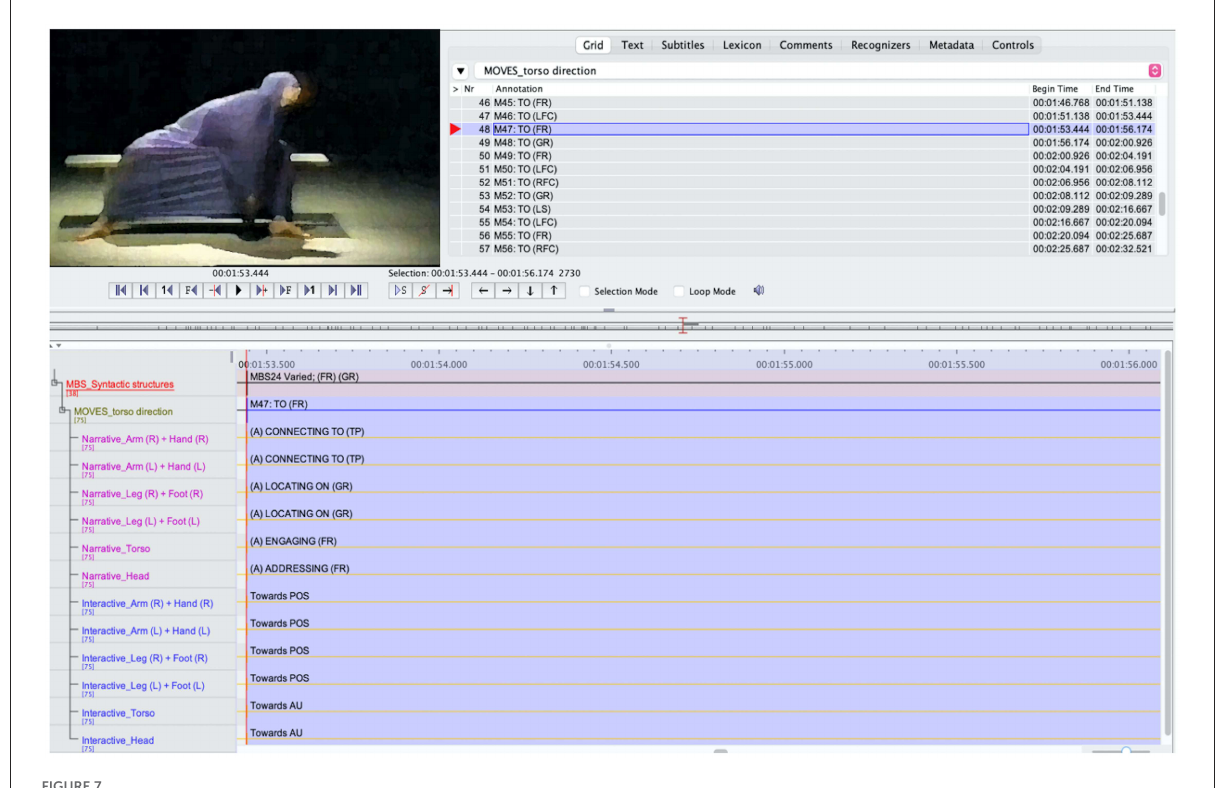
FIGURE7 ELAN’s Annotation working mode and its Grid Viewer (showing move 47 and its default media